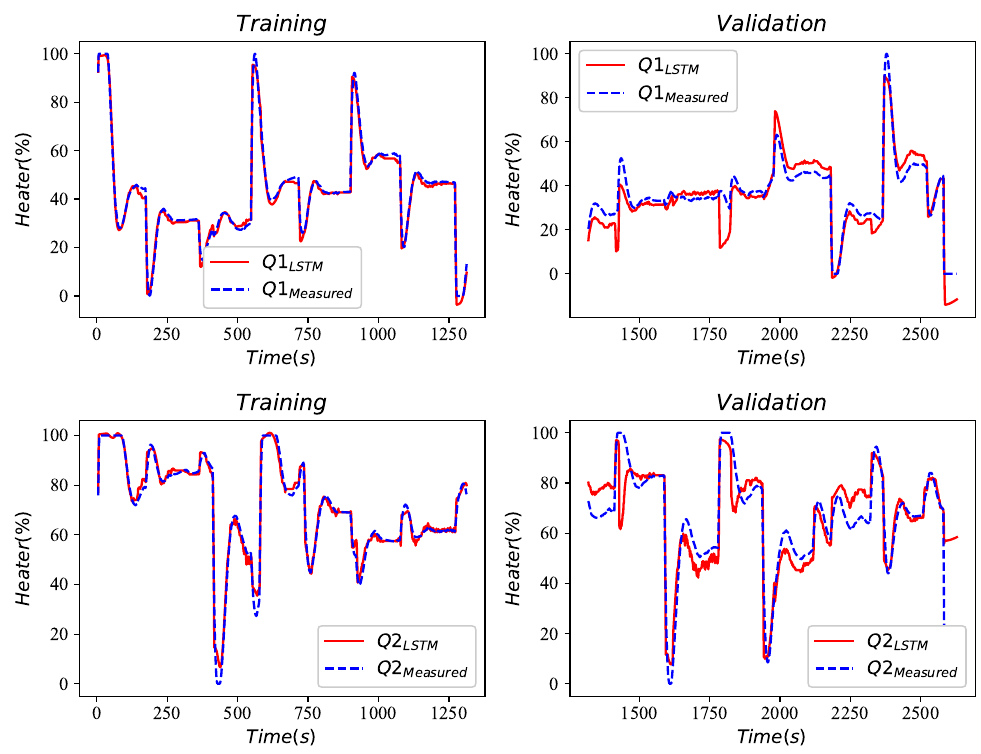
Figure 5. Training and validation fit from training an LSTM to learn the control actions of the target system. The model is trained on 2600 points of data for 300